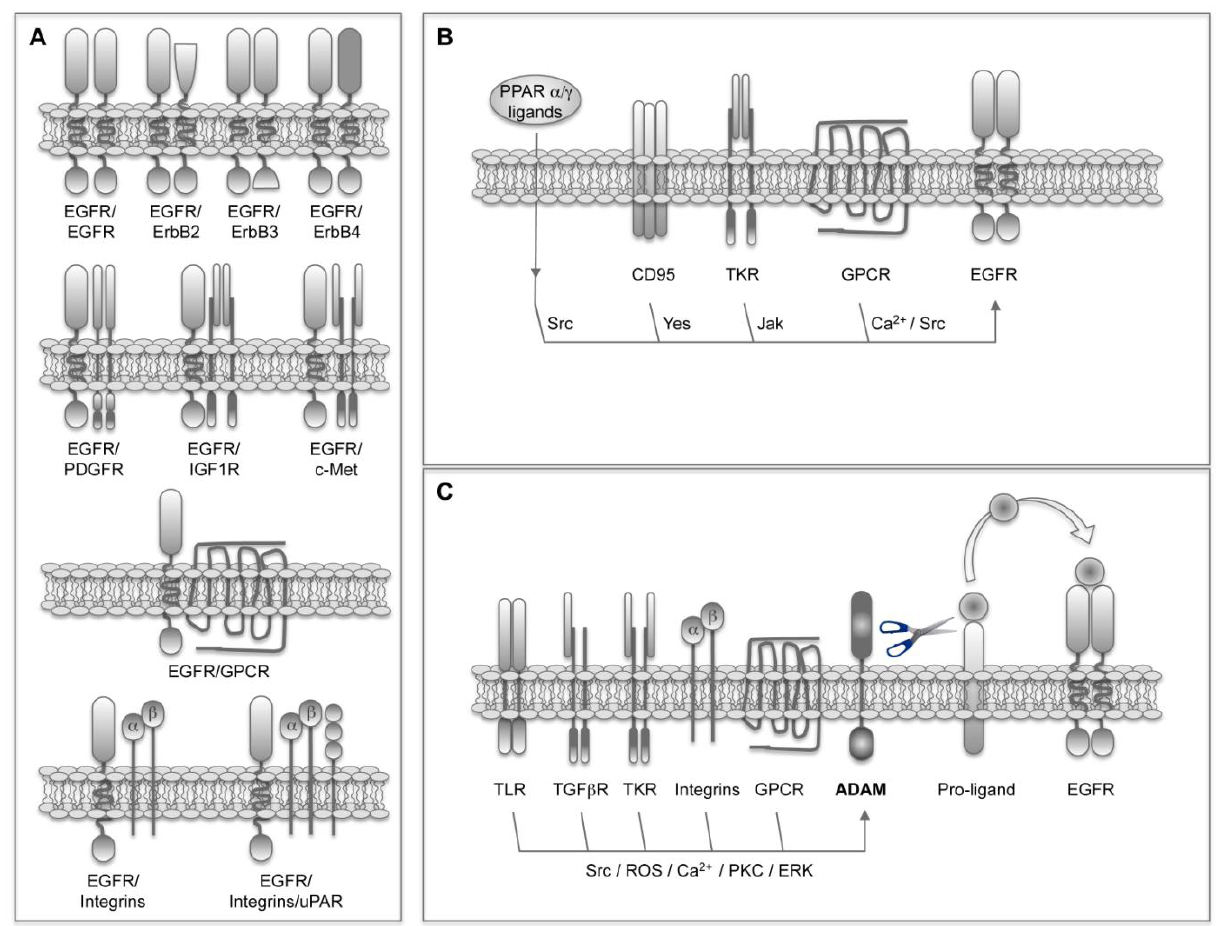
Figure 1. Epidermal growth factor receptor (EGFR) crosstalk. ( A ). EGFR physical interactions or heterodimerization with other membrane receptors. EGFR is able to bind to other receptors including other members of the ErbB family, TKRs, GPCRs and integrins; ( B ). Ligand-independent transactivation of EGFR; ( C ). Ligand-dependent transactivation of EGFR, or triple-membrane-passing signal (TMPS) pathway. Ligand-binding to TLRs, TGF  R, TKRs, integrins and GPCRs activates ADAM transmembrane metalloproteases resulting in the shedding of EGFR-ligands and the activation of